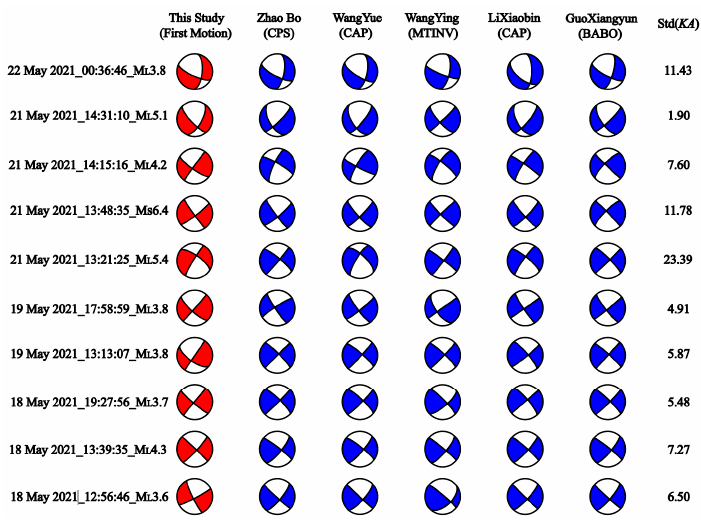
Figure 4. Comparison of focal mechanism solutions between different studies. The leftmost column is the earthquake information; the rightmost column is the standard deviation of the Kagan angle.